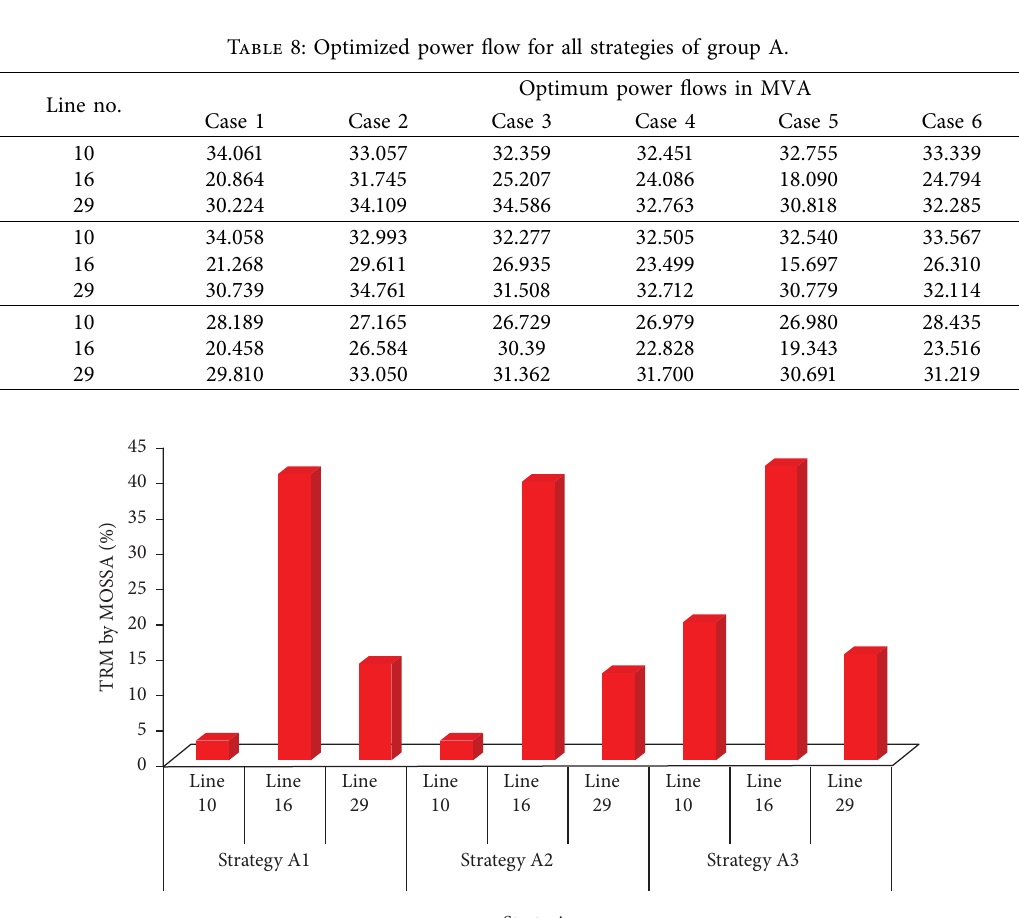
Figure 6: Percentage Improvement in TRM over critical lines for group A.